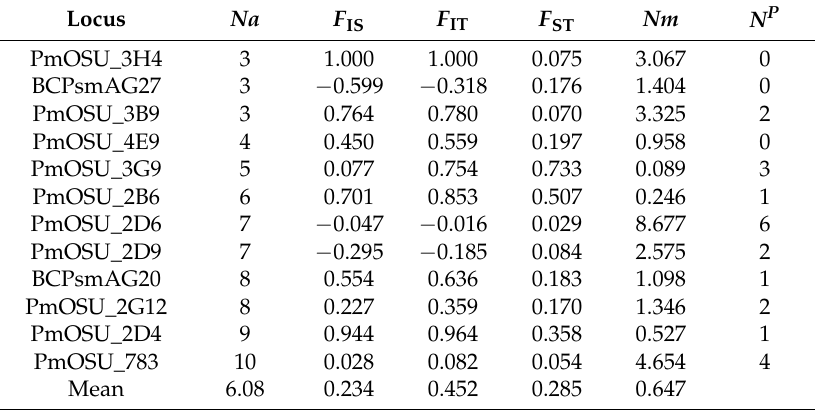
Table 3. Average estimates of parameters fixation indexes, gene flow, and private alleles in the 12 pairs of microsatellites